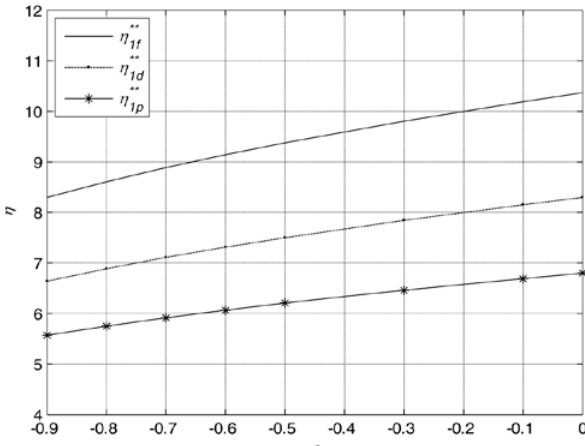
fig. 3. Impacts of ρ on investment thresholds of agent 1 note: all the parameter values are set as follows: r = 0.05, I = 100, D (1) = 1, D (2) = 0.8, µ = 0.02, a 0.01, σ = 0.2, c = 0.1, c = i j